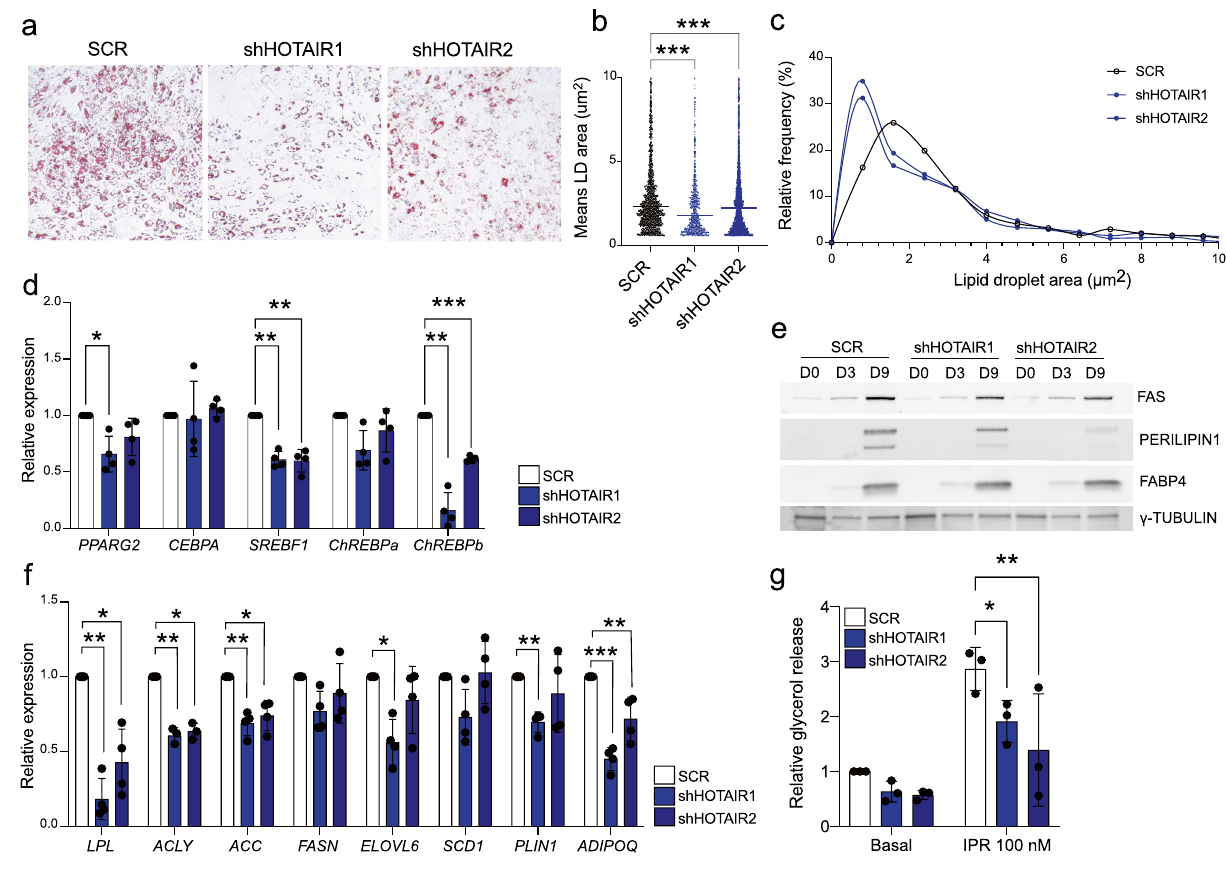
Figure 4. HOTAIR KD impairs lipid storage in mature adipocytes.( a ) Oil red O staining (20X) of differentiated (D9) SCR and sh HOTAIR G-ASCs. Lipid droplet area analysis from PERILIPIN immunostainings of differentiated (D9) SCR and HOTAIR KD G-ASCs presented as ( b ) individual data scatter plot and mean (*** p < 0.0001, two-way ANOVA with Dunnett’s multiple comparisons test; n = 3 experiments, with ≥ 3 fields measured per experiment) and ( c ) distribution frequency. ( d ) RT-qPCR analysis of adipogenic transcription factor gene expression at D9 (mean fold difference ± SD; * p < 0.05, ** p < 0.005, *** p < 0.001, two-way ANOVA with Dunnett’s multiple comparisons test; n = 4). ( e ) Western blot analysis of fatty acid synthase (FAS), PERILIPIN1, and FABP4 in differentiating SCR and shHOTAIR G-ASCs (representative blot from n = 3; see Fig. S7for original blots). γ-Tubulin is shown as a loading control. ( f ) RT-qPCR analysis of glucose- and lipid uptake-related genes, de novo lipogenesis genes and mature adipocyte markers in differentiated (D9) SCR and shHOTAIR G-ASCs (mean fold difference ± SD; * p < 0.05, ** p < 0.005, two-way ANOVA with Dunnett’s multiple comparisons test; n = 4). ( g ) Fold induction of glycerol release in response to 100 nM isoproterenol stimulation for 2 h in differentiated (D9) SCR and shHOTAIR G-ASCs (mean fold difference ± SD; * p < 0.05, ** p < 0.005, two-way ANOVA with Dunnett’s multiple comparisons test; n =